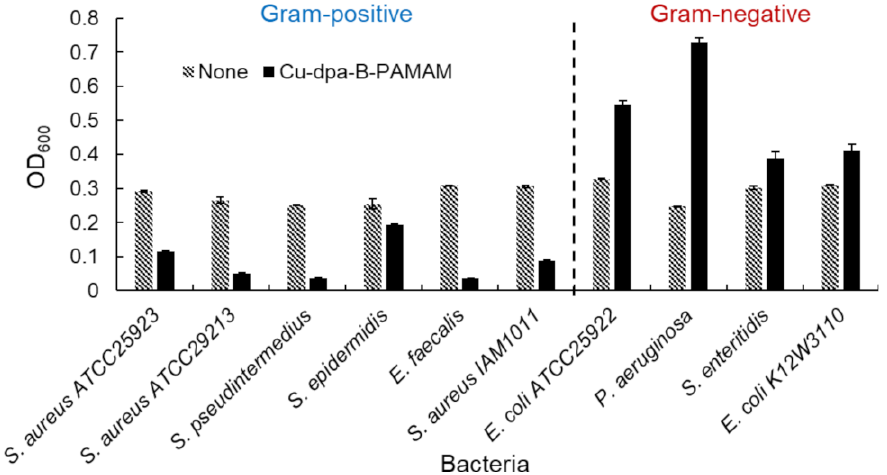
Figure 6. Turbidity experiments using various bacteria ( n = 3). [Cu-dpa-B-PAMAM] = none or 3.3 µ M; [Cu 2+ ] = none or 13.2 µ M; bacterial concentration was set at OD 600 = 0.3; [HEPES] = 5.0 mM. Bars are expressed as SD for three separate experiments. Each bacterial suspension containing Cu-dpa-B-PAMAM could be discriminated from the suspension without the probe ( p < 0.05: S. au- reus ATCC25923: 1.2 × 10 − 7 , S. aureus ATCC29213: 4.5 × 10 − 4 , S. pseudintermedius : 1.0 × 10 − 8 , S. epidermidis : 1.4 × 10 − 4 , E. faecalis : 1.4 × 10 − 9 , S. aureus IAM1011: 7.3 × 10 − 5 , E. coli ATCC25922: 9.6 × 10 − 4 , P. aeruginosa : 5.6 × 10 − 4 , S. enteritidis : 2.6 × 10 − 2 , E. coli K12W3110: 1.5 × 10 − 2 ). The suspensions containing Gram-positive bacteria and Cu-dpa-B-PAMAM could be discriminated from suspensions containing Gram-negative bacteria and Cu-dpa-B-PAMAM ( p < 0.05). The number of dpa modifications was 4 and that of boronic acid modifications was